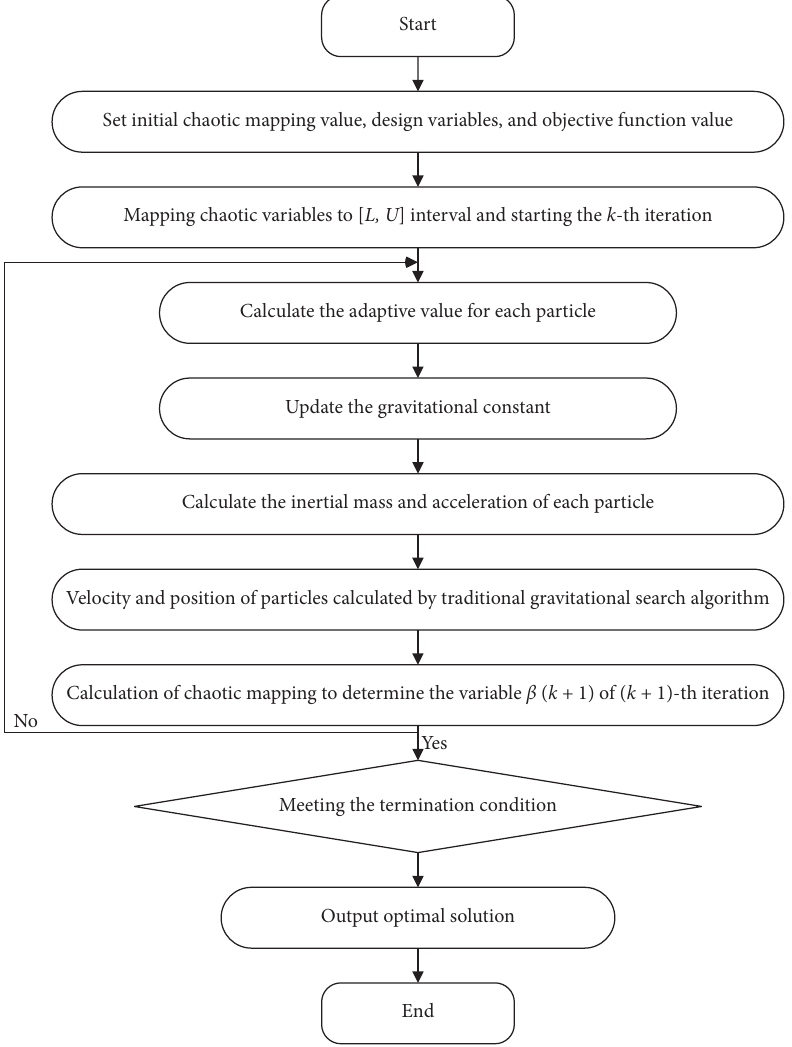
Figure 2: Flowchart of improved gravity search algorithm based on chaotic